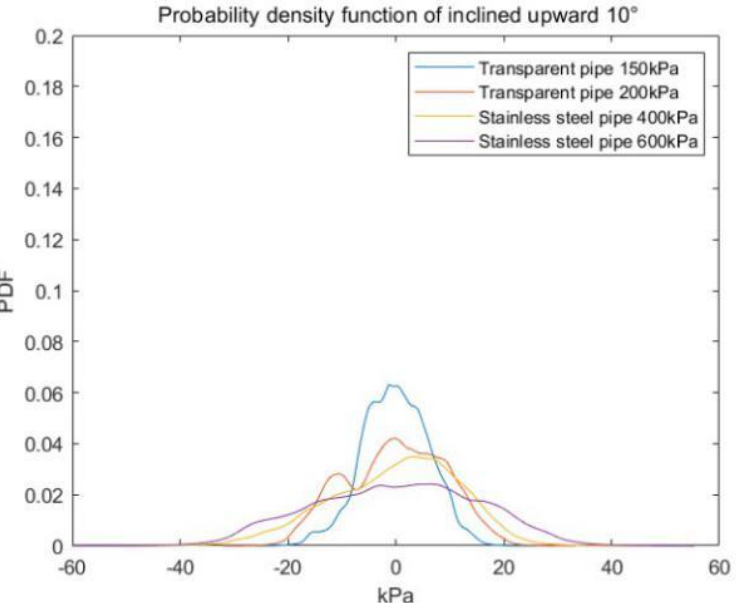
Figure 8. Probability density function of inclined upward by 10°.